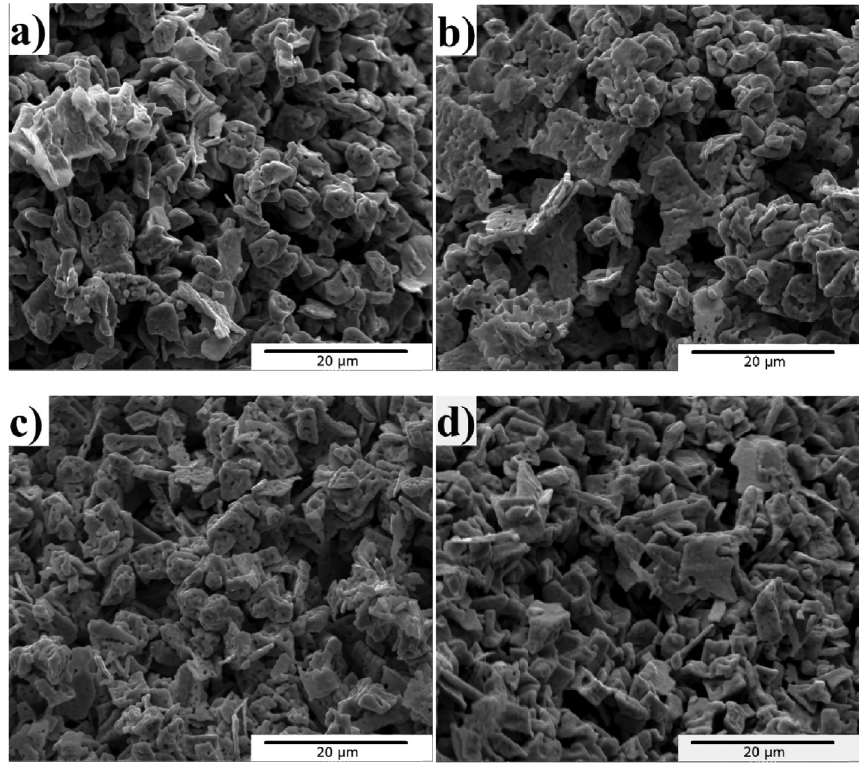
Fig. 8: Morphologies of Mo by reducing MoO 2 powders at 1323 K in H 2 -Ar: (a) 25% H 2 , (b) 50% H 2 , (c) 75% H 2 , (d) 100% H 2 (SEM ×5000)